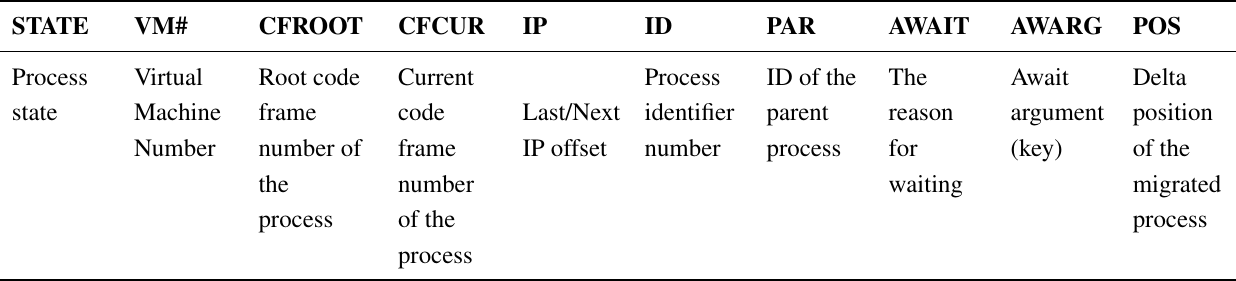
Table 1. Process table (PT) row format and